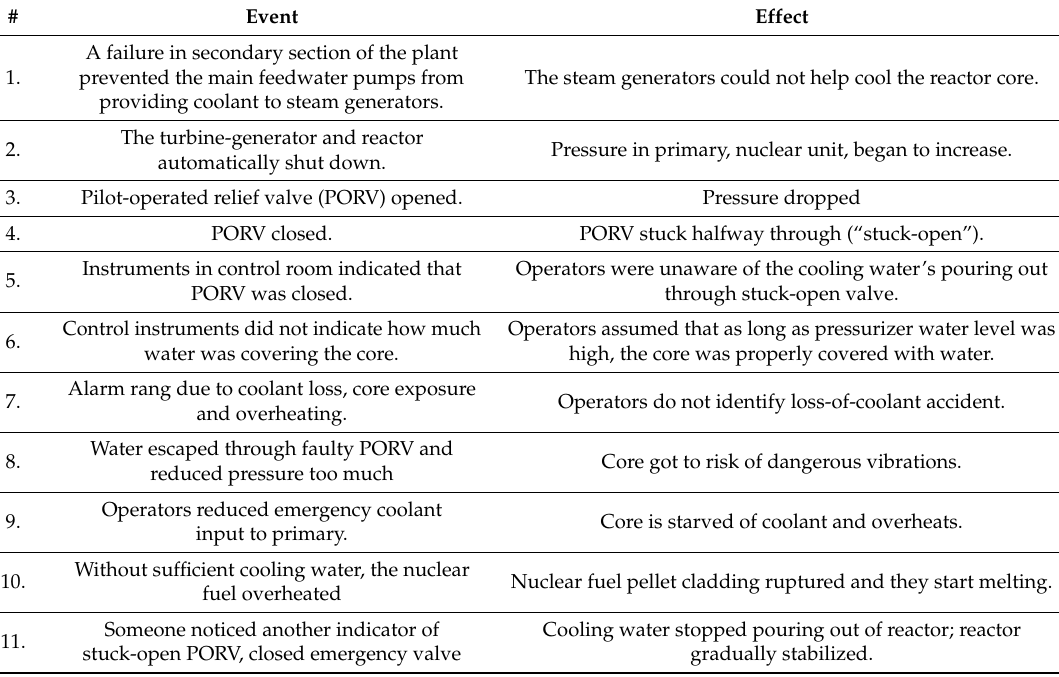
Table 3. Three-Mile Island 2 accident course of events